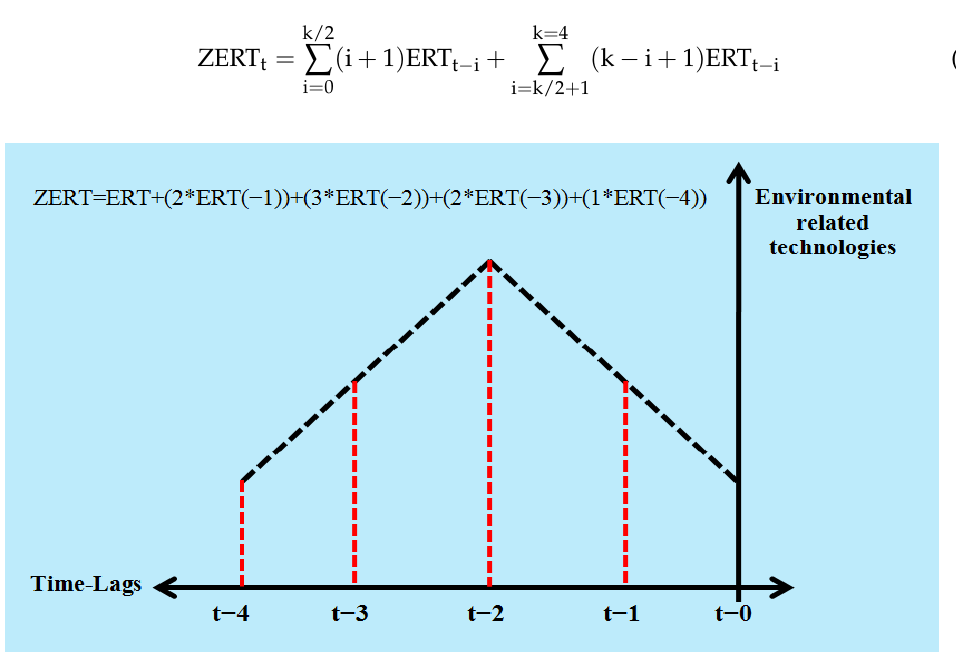
Figure 1. De Leeuw’s Finite Lags Distribution Scheme for Environmental-related technologies.